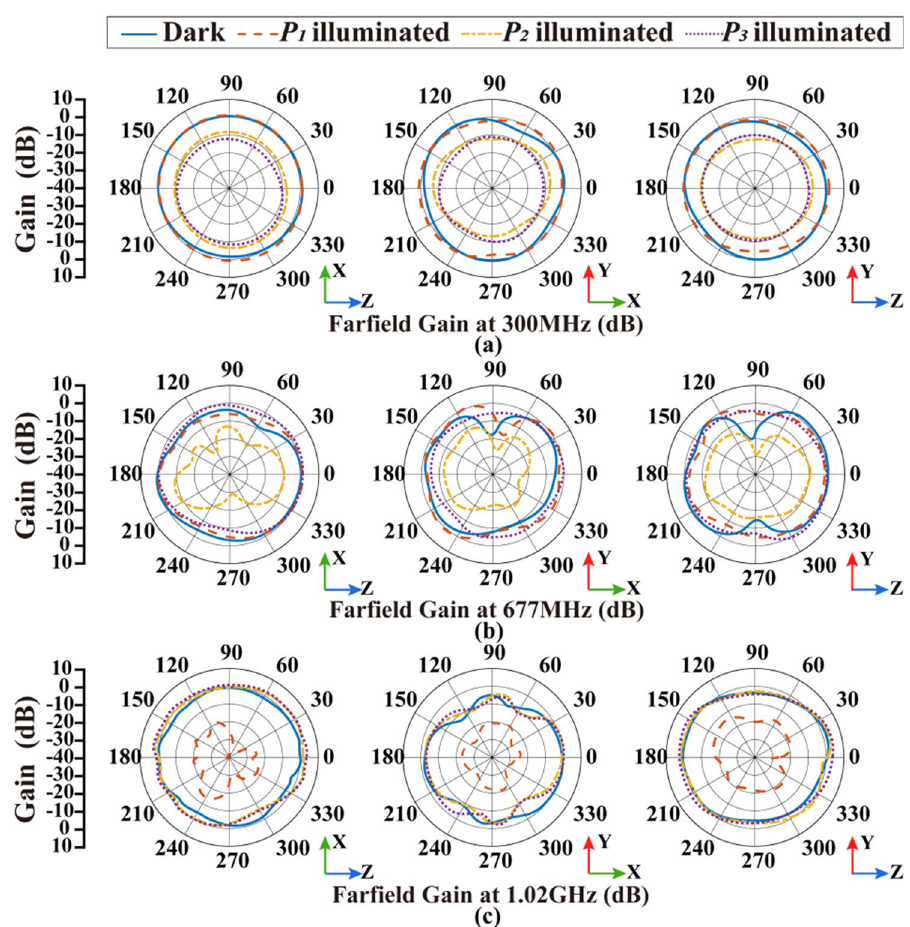
Figure 11. Measured results of radiation patterns under different illumination conditions: ( a ) radiation pattern at 300 MHz, ( b ) radiation pattern at 677 MHz, ( c ) radiation pattern at 1.02